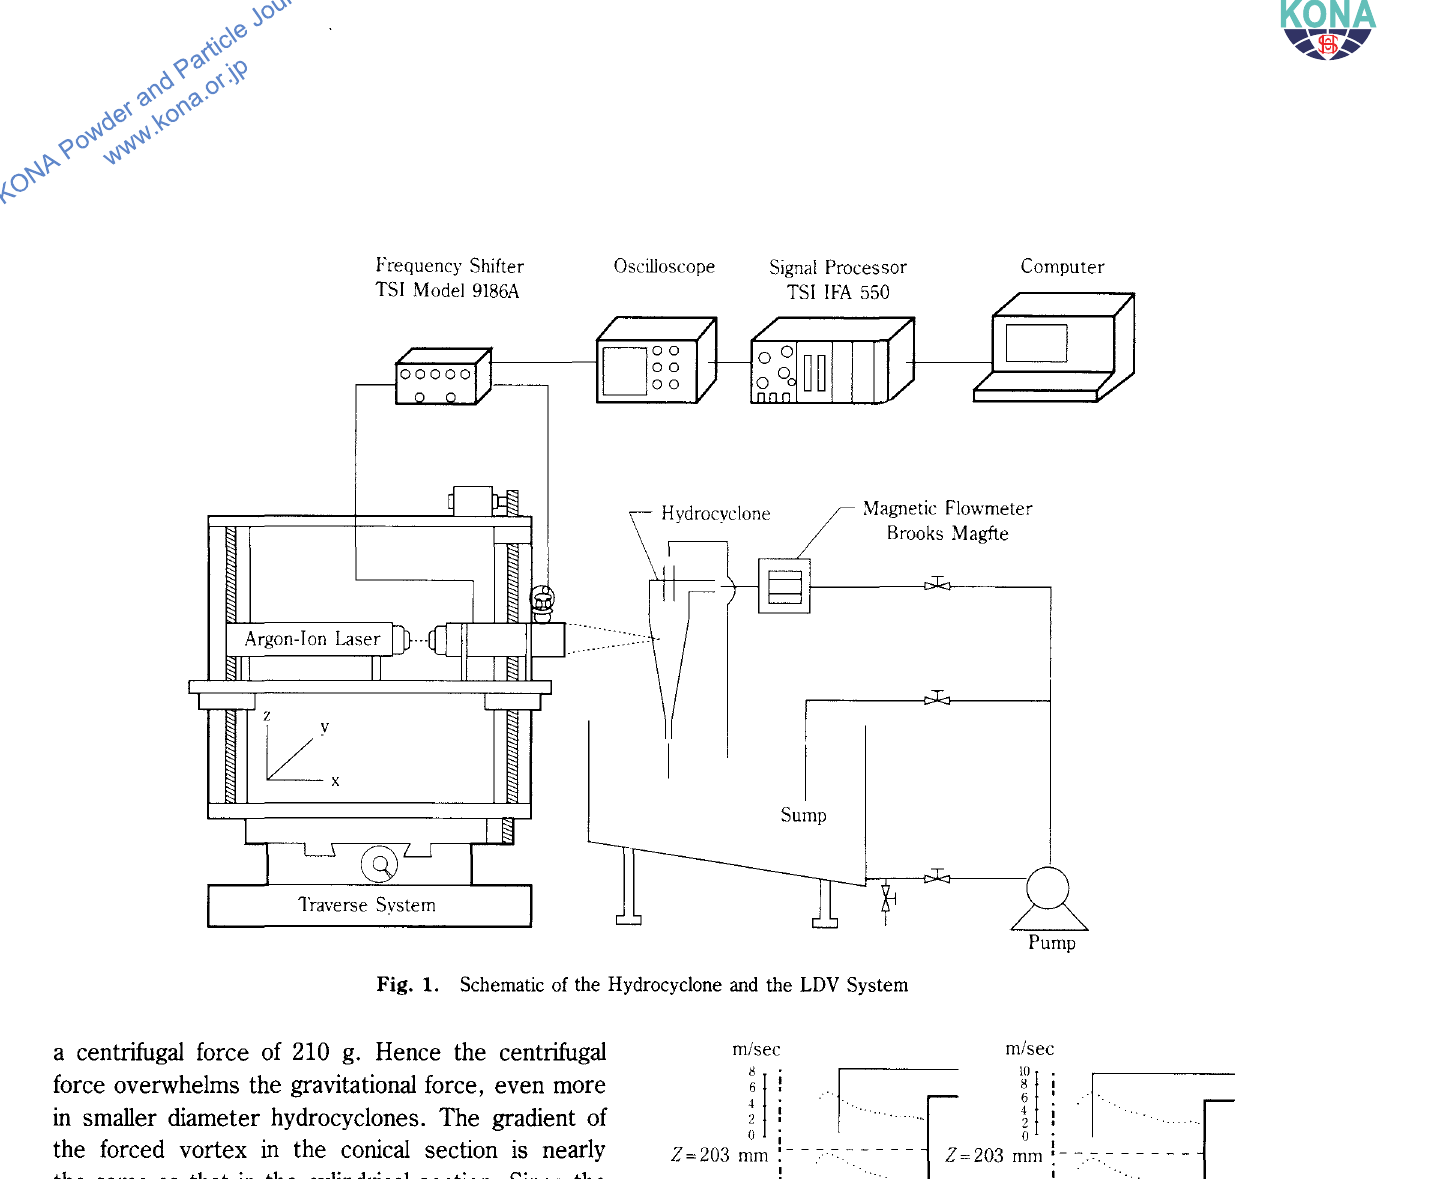
Fig. 1. Schematic of the Hydrocyclone and the LDV System